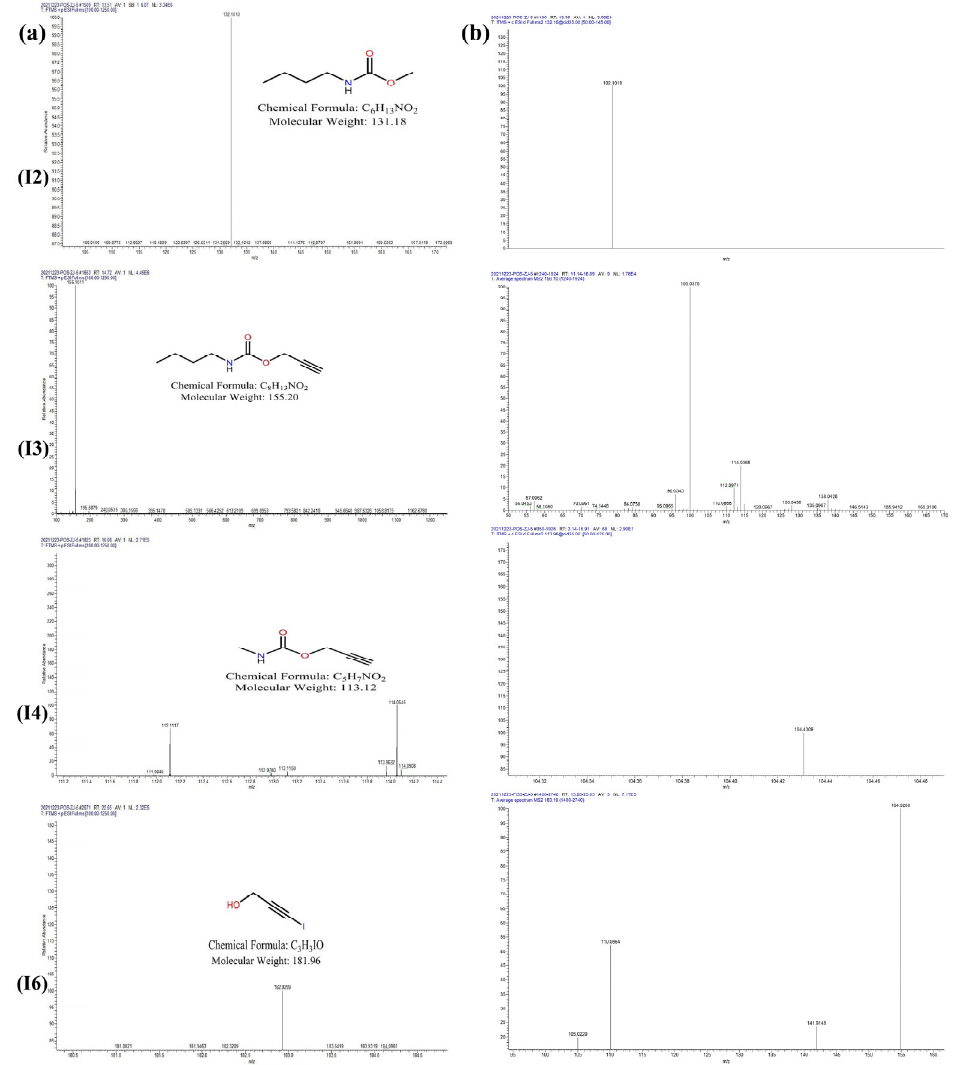
Figure 8. Total ion current chromatogram of IPBC degradation by UPLC − MS/MS.